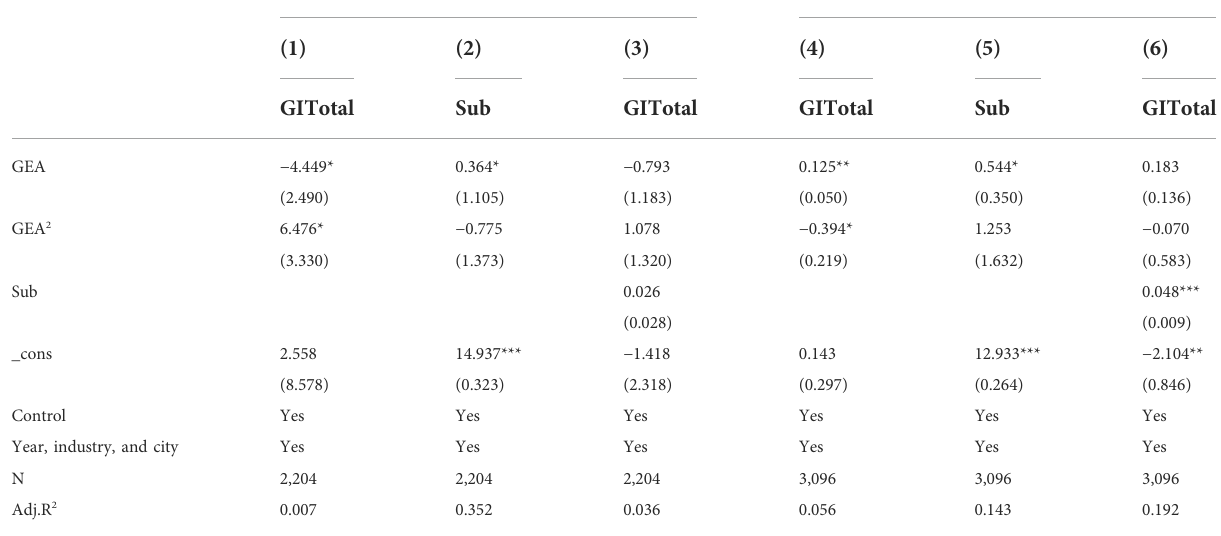
TABLE 6 Mechanism of the environmental